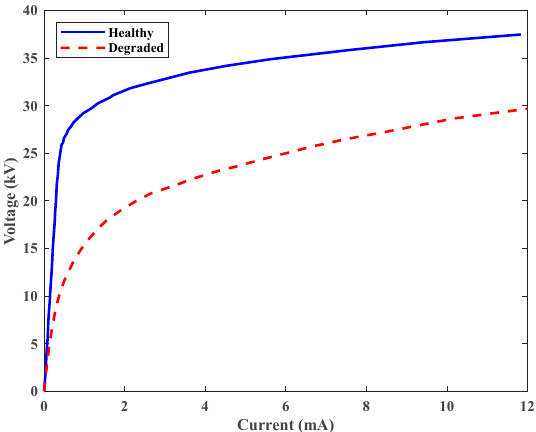
Figure 7. V-I characteristics of healthy and degraded MOSAs.